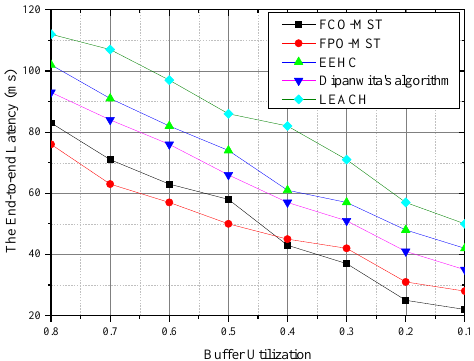
Figure 12. Comparison of E2EL under different buffer utilization.